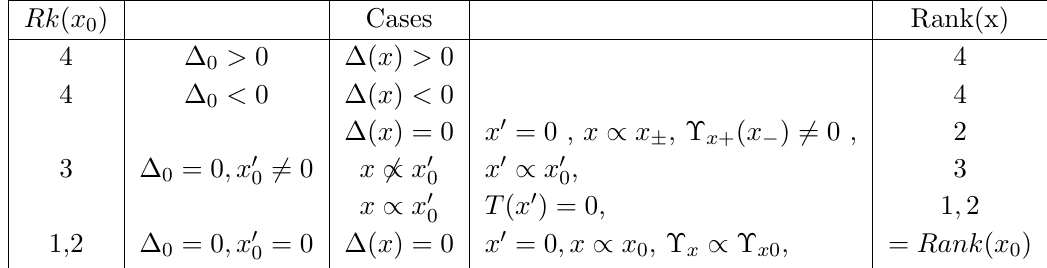
Table 2 . Relation of rank( x ), the rank of any element x in the T -plane T 0 generated by x 0